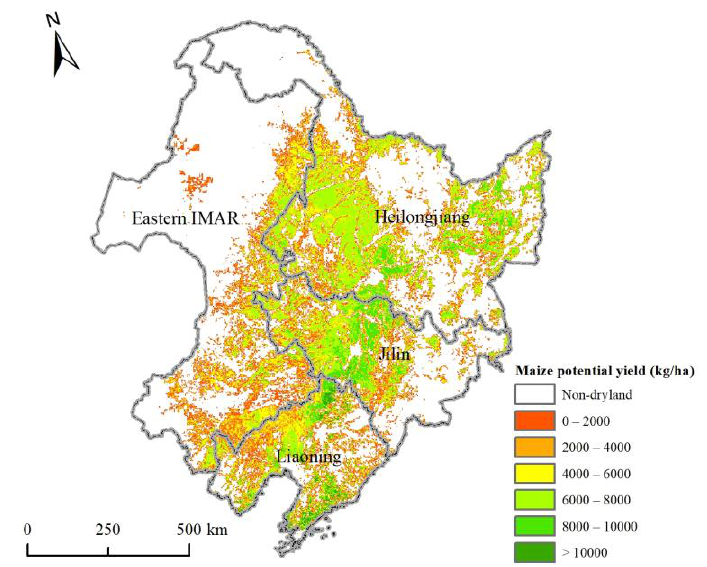
Figure 6. Spatial distribution of maize potential yields in Northeast China in 2050.